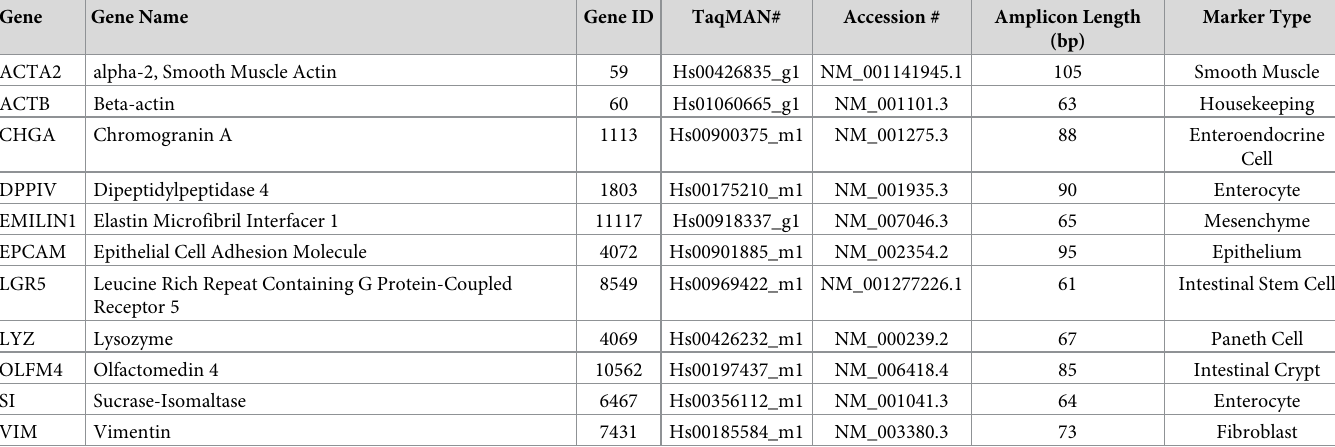
Table 2. TaqMan probe information for transcript